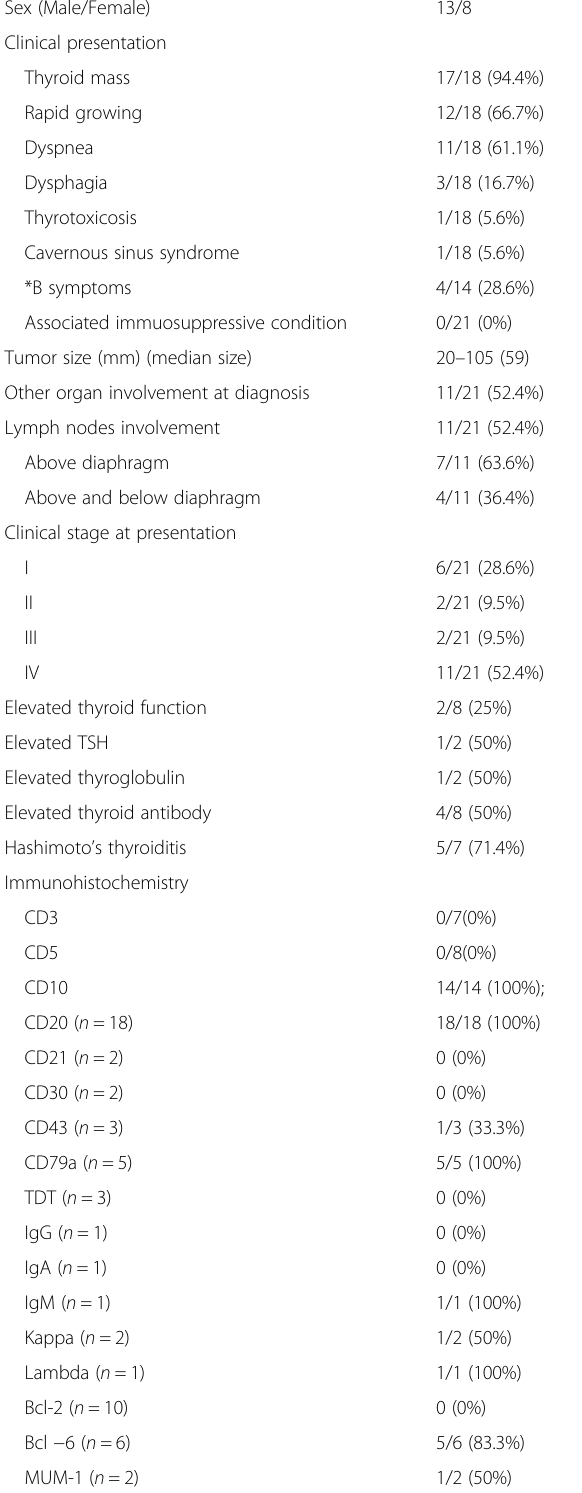
Table 1 Clinicopathological characteristics of 21 thyroid Burkitt ’ s lymphomas by meta-analysis of the literature